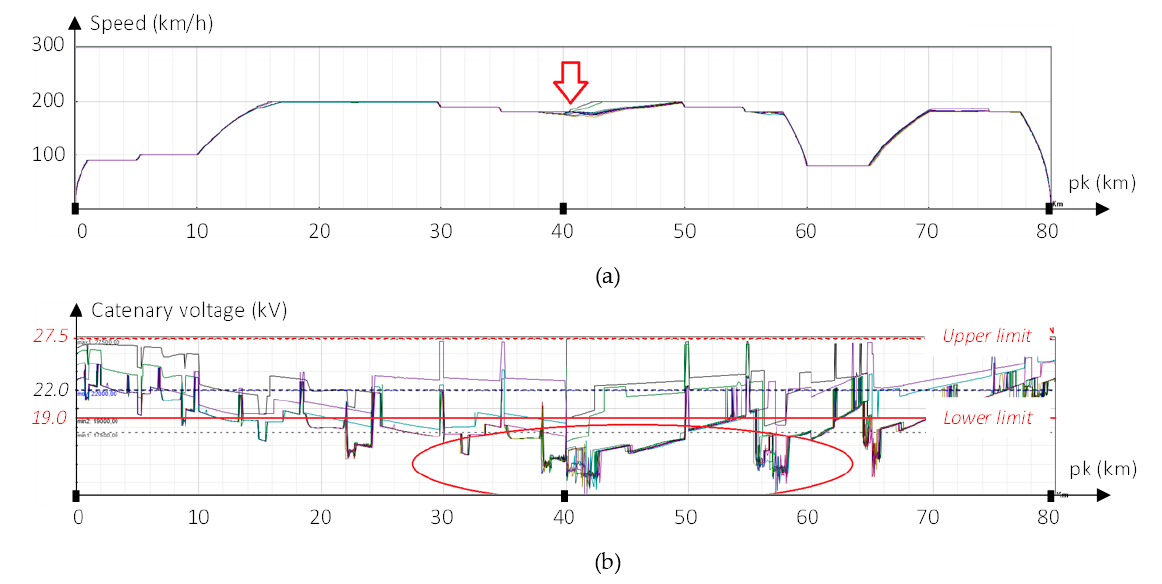
Figure 8. Simulation results for the degraded case: ( a ) speed profiles, showing that the speed of the trains is affected between pk = 40 km and pk = 50 km; ( b ) catenary voltage. The red continuous line represent the lower limit (19 kV) and the red dashed line represents the upper limit (27.5 kV). The voltage locally drops below 19 kV (red ellipse).